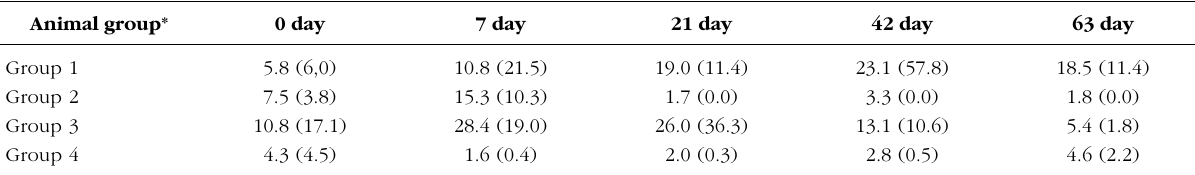
Table i. – geometric Mean lpg and Median (between brackets) in the different groups of